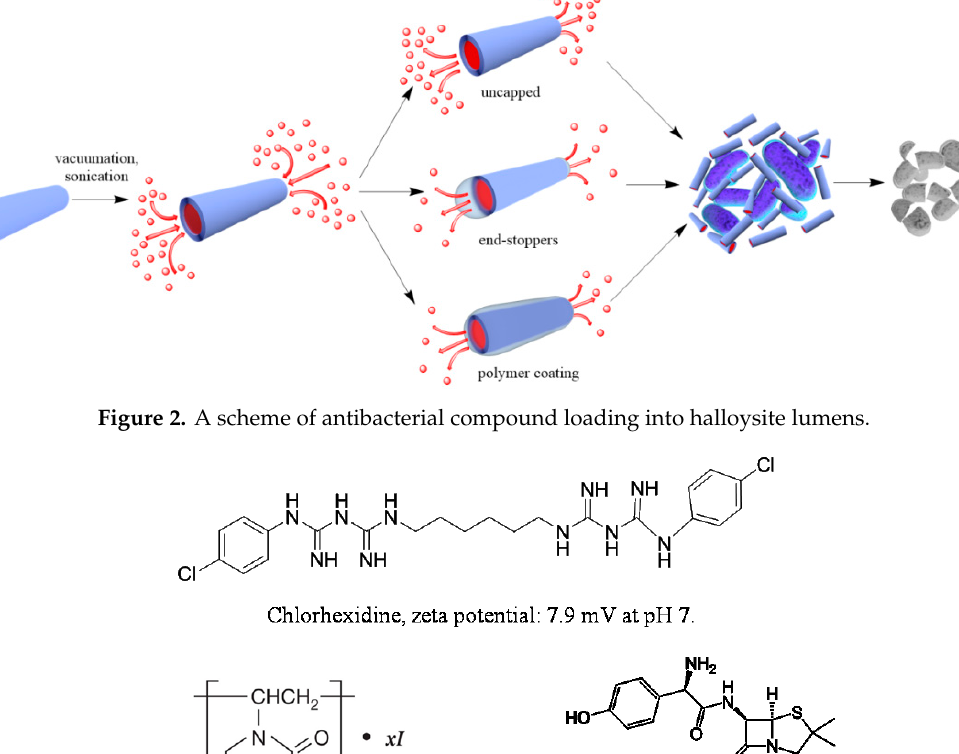
Figure 3. Chemical structure and zeta potential at pH 7 of commonly used antibacterial compounds.